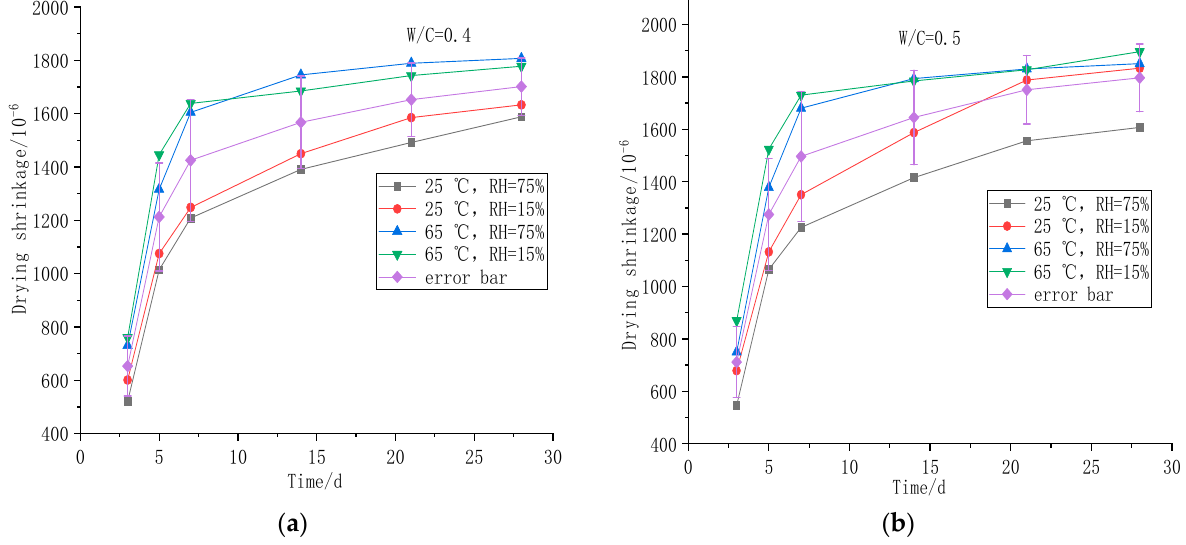
Figure 6. Drying shrinkage of foamed concrete at different curing temperatures: ( a ) 0.4 water–cement ratio dry shrinkage of foamed concrete; ( b ) 0.5 water–cement ratio dry shrinkage of foamed concrete.